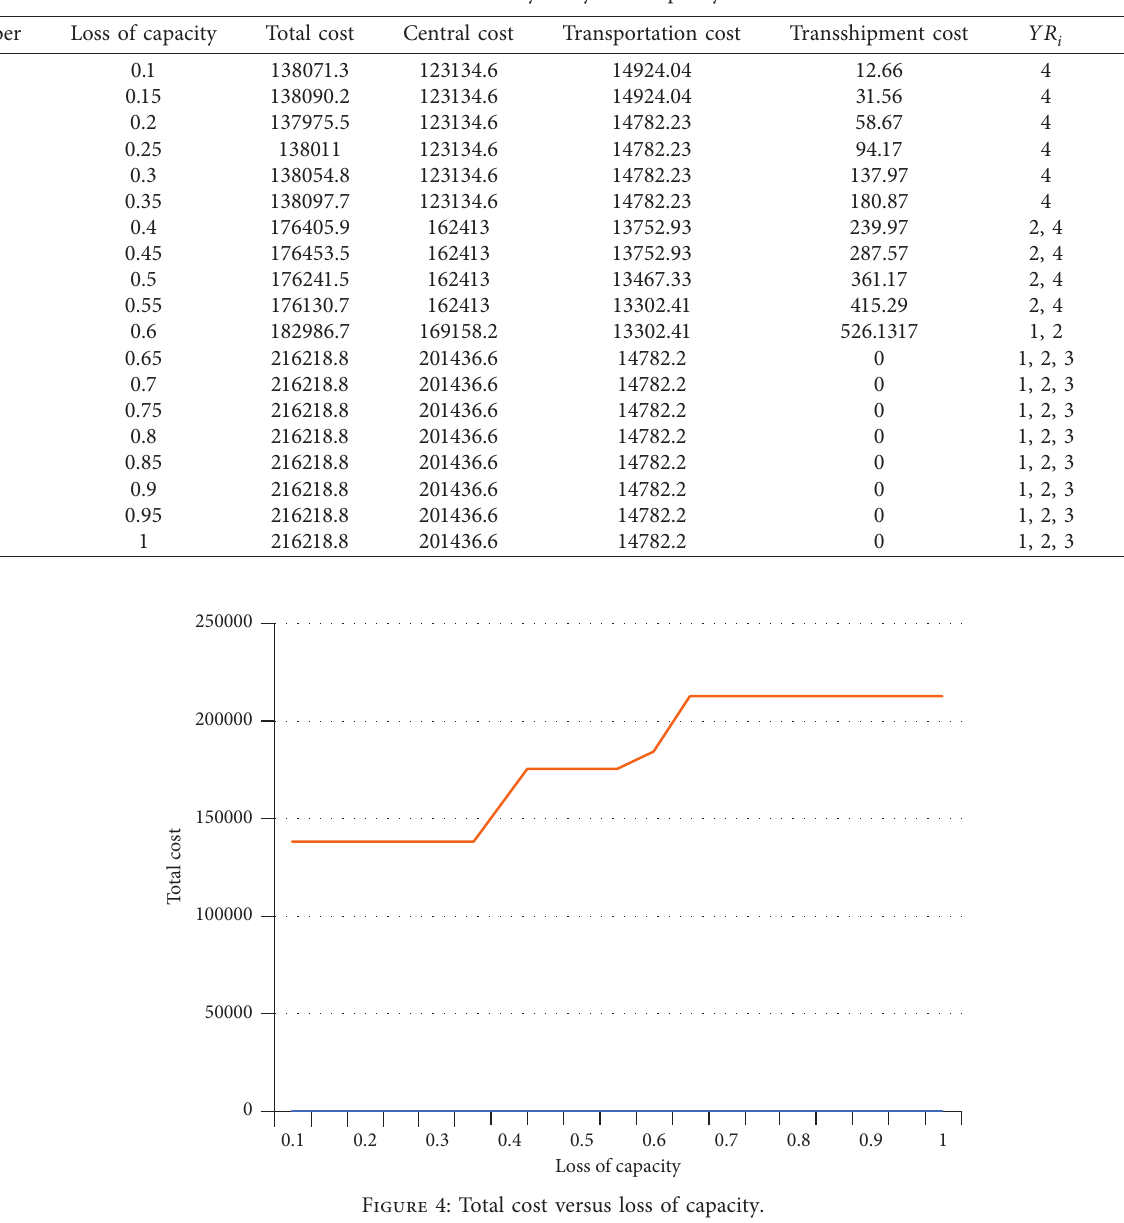
Table 3: Sensitivity analysis of capacity loss.